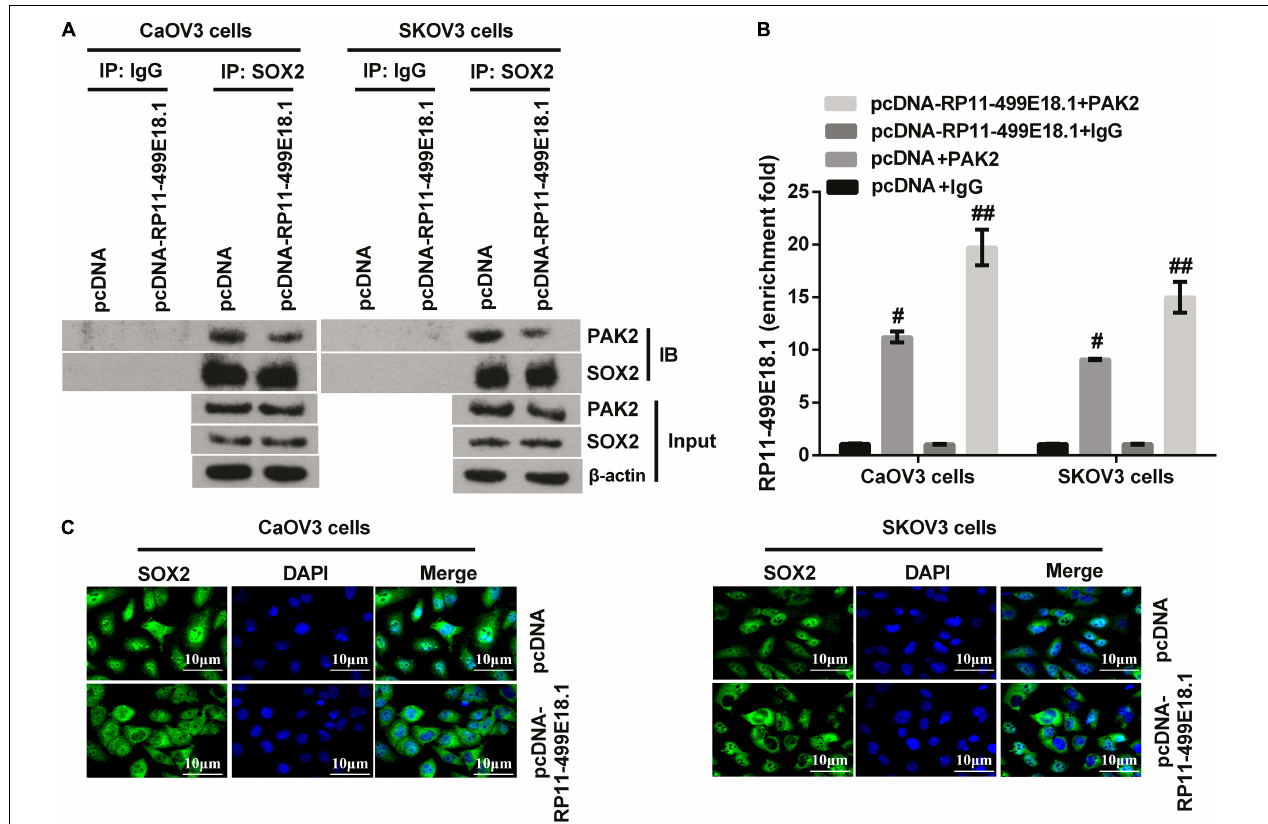
FIGURE 7 | RP11-499E18.1 overexpression reduced the interaction between PAK2 and SOX2, and increased the binding of RP11-499E18.1 by PAK2. (A) Co-IP assay confirmed that RP11-499E18.1 overexpression remarkably reduced the interaction between PAK2 and SOX2. (B) RIP assay affirmed that RP11-499E18.1 overexpression notably increased the binding of RP11-499E18.1 by PAK2. (C) Overexpression of RP11-499E18.1 remarkably decreased the nuclear translocation of SOX2 in CaOV3 and SKOV3 cells. Co-IP, co-immunoprecipitation; RIP, RNA immunoprecipitation; PAK2, P21 (RAC1) activated kinase 2; SOX2, SRY-box transcription factor 2. # p < 0.05, ## p <